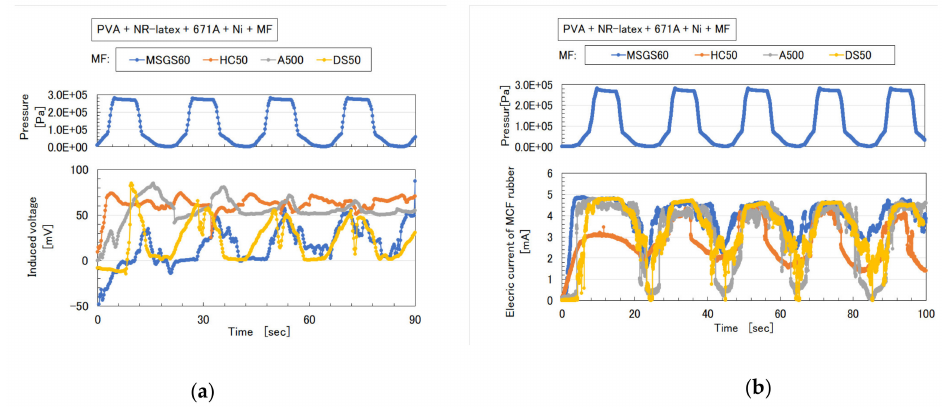
Figure 10. Induced voltage and electric current as piezo-resistivity of MCF rubber with water-insoluble MF to repeat pressure application in Figure 7: ( a ) piezo-electricity; ( b )